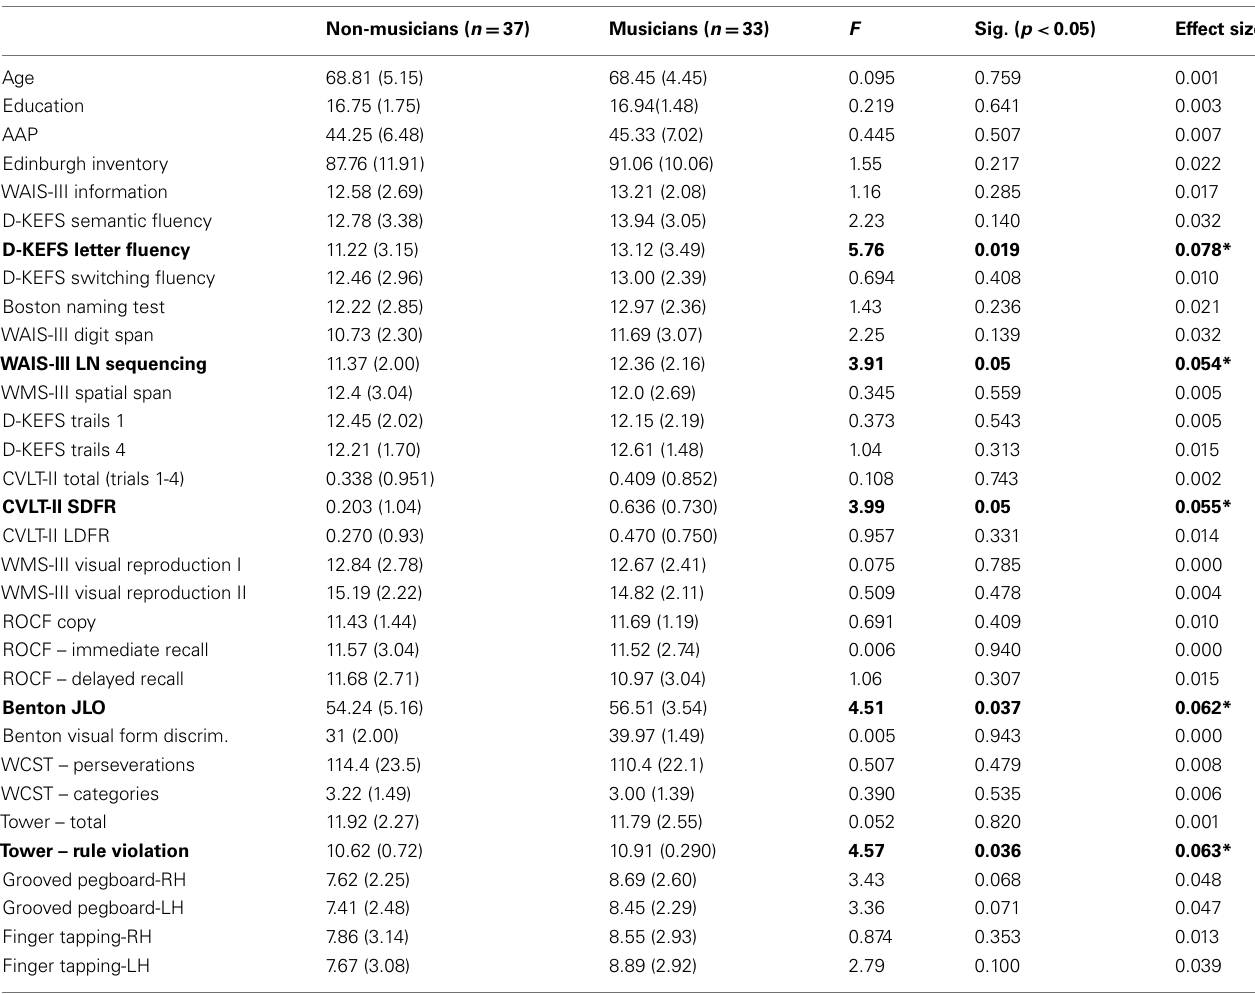
Table 1 | Means (SDs) for demographics and scaled scores for neuropsychological